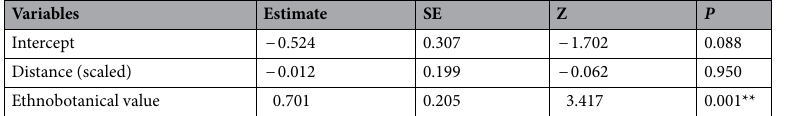
Table 3. Beta regression testing the effect of the distance between agroforestry systems and their surrounding vegetation and ethnobotany value on the proportion of shared species. Distance was standardized.